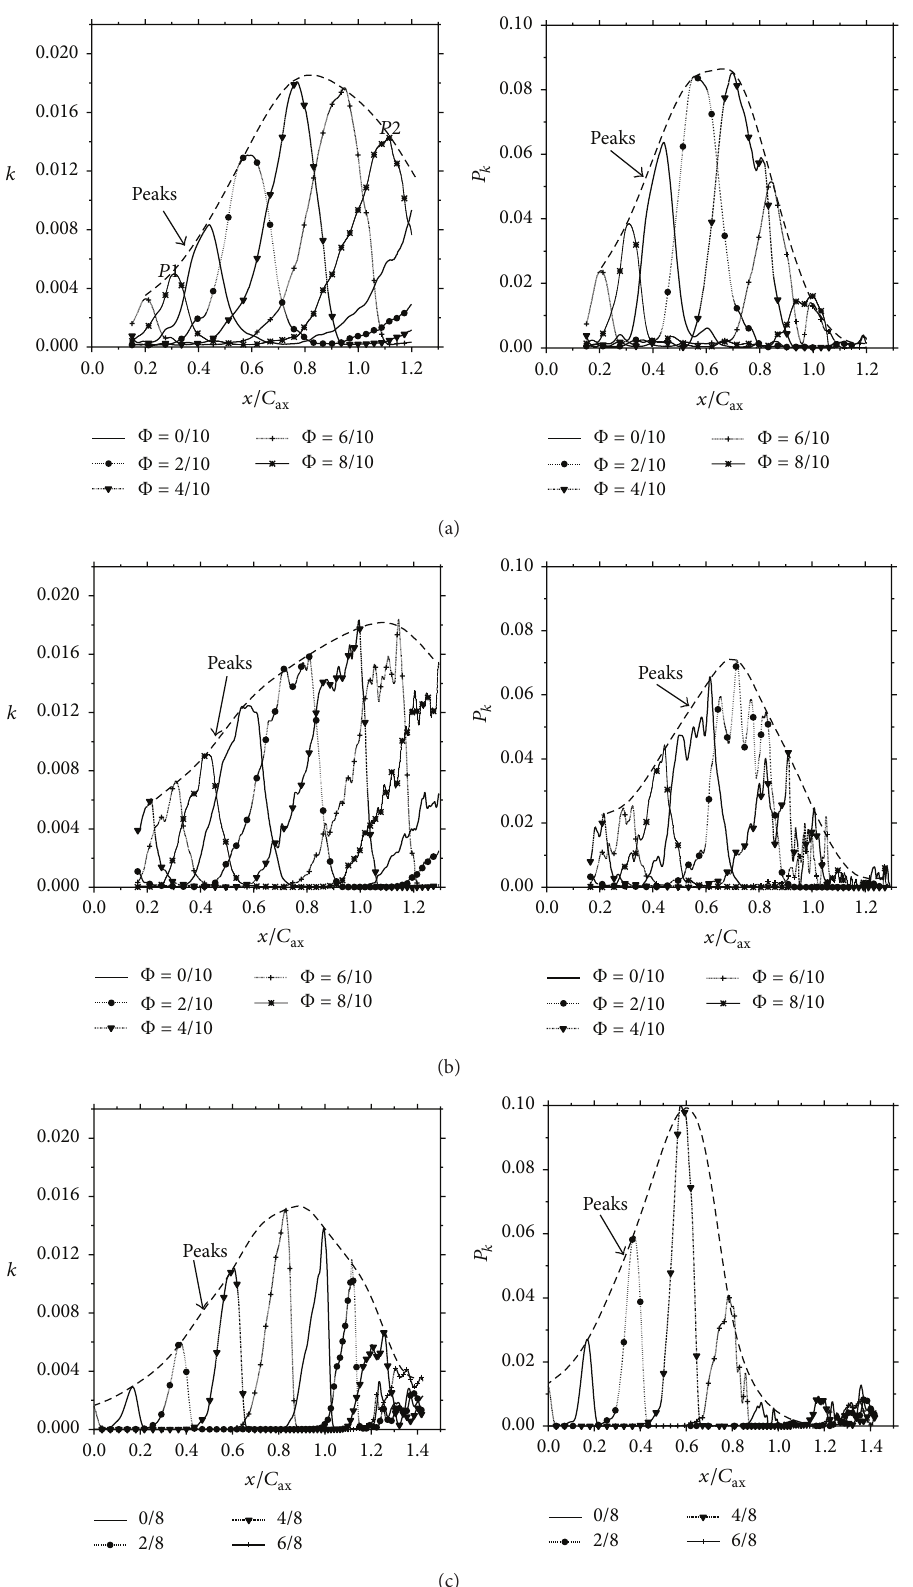
Figure 5: Peaks of turbulent kinetic energy, 𝑘 , and production rate, 𝑃 𝑘 , along line 𝑃 versus the axial coordinate in the blade vane: (a) LES: Re = 5.18 × 10 4 , (b) DNS: Re = 5.18 × 10 4 , and (c) LES: Re = 1.48 × 10 5